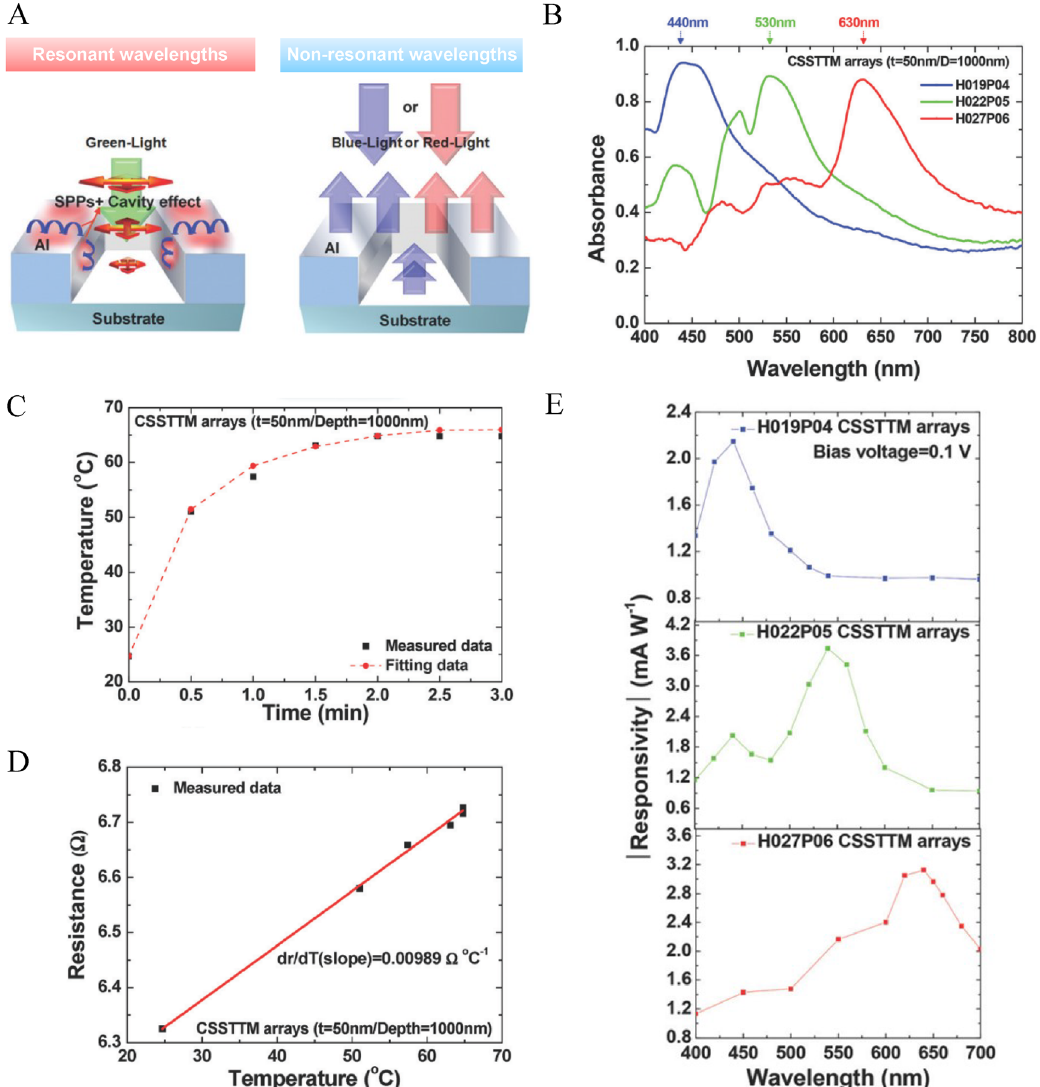
Figure 14: (A) Schematic representation of the photothermal behaviors of trench-like structured metal film at resonant and non-resonant wavelengths. (B) Measured absorption spectra of trench-like structured metal film having different structural parameters. (C) Correlation between temperature and time for the trench-like structured metal film having hole of 270 nm and period of 600 nm in the dark and under illumination of light with power density of 1.1 W cm − 2 . (D) Resistance of trench-like structured metal fi lm at different temperatures. (E) Spectral photoresponsivity of the trench-like structured metal fi lm having different structural parameters measured at a bias voltage of 0.1 V